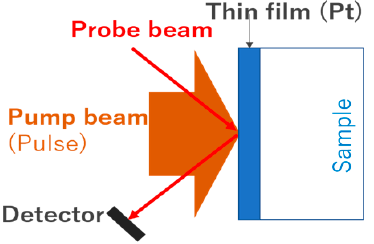
Figure A1. Diagram of thermo-reflectance measurement with FF configuration.